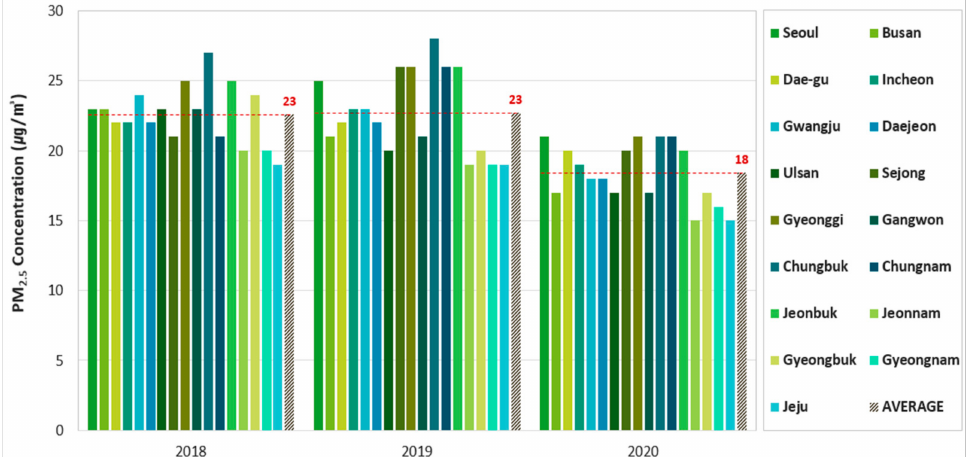
Figure 10. Average PM 2.5 concentrations by city/province in South Korea and by year from 2018 to 2020